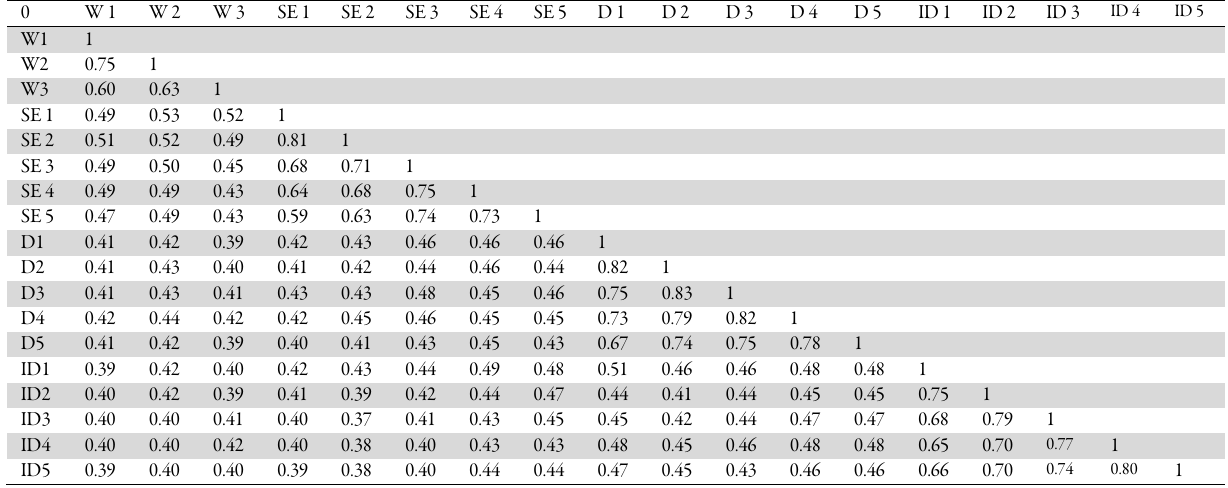
Table 8. Jaccard’s similarity coefficient based on combined data analysis ofISSR, RAPD, cpSSR for wild plants (W), in vitro regenerated plants through somatic embryogenesis(SE), direct organogenesis(D) and indirect organogenesis (ID)